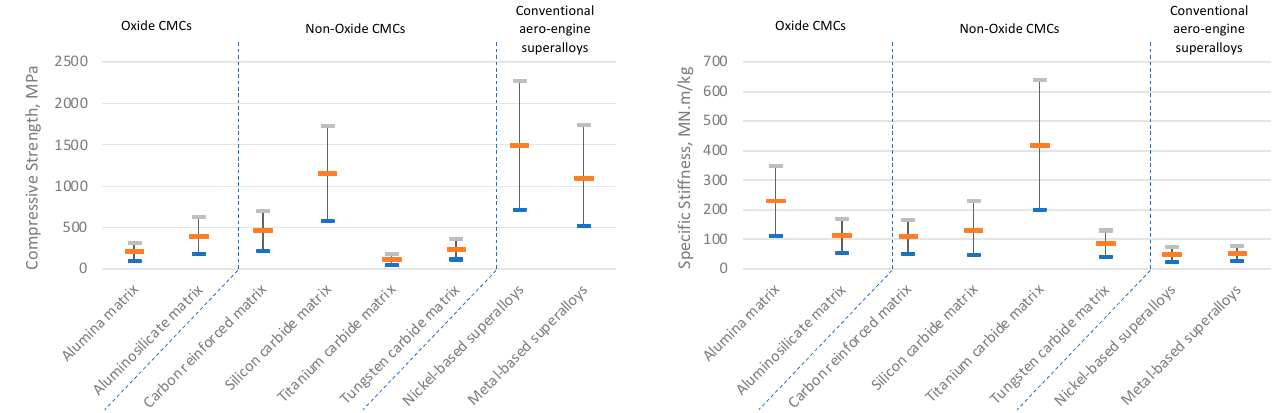
Figure 8. ( Left ) Compressive strength and ( right ) specific stiffness of available CMCs and comparison with superalloys.